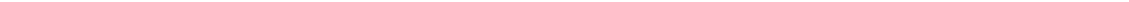
Fig. 1 Sample collection and fecal microbiota composition of WLGs and chimpanzees compared to humans and other non-human primates. a WLG ( G. g. gorilla )-photo by T. Breuer/WCS. b Collection sites of the 87 WLG and 18 chimpanzee fecal samples (dark blue and turquoise dots, respectively). All collection coordinates were east of Odzala-Kokoua National Park in the Sangha region of the Republic of the Congo. Raw spatial fi les were sourced from public or open source databases, including Map Library (www.maplibrary.org; Africa and Republic of Congo), The World Bank Data Catalog (https:// datacatalog.worldbank.org; roads), Humanitarian OpenStreetMap Team (https://data.humdata.org; rivers) and the World Resource Institute Congo Basin Forest Atlases (www.wri.org/our-work/project/congo-basin-forest-atlases; Odzala). Maps were created and modi fi ed with R version 3.4.0, Inkscape and Gimp software. c Box-and-whiskers plots showing the distributions of all bacterial phyla (left of dotted line), as well as the 30 most abundant bacterial genera (right of dotted line) in feces from the 87 WLGs in this study. Phyla and genera labels in red with asterisks indicate bacterial taxa identi fi ed by LEfSe as being elevated in WLGs compared to other host types (see Fig. 2a). Phyla and genera labels preceded by “ u ” represent taxonomic groups that could only be classi fi ed at higher taxonomic levels. d Alpha diversity rarefaction plot based on the observed genera metric. Mean observed genera for each host type are shown with the standard error of the mean. e PCoA plot based on the BC dissimilarity among bacterial genus-level abundance distributions for each host type. Color designations for each host type shown in d , e are indicated at the